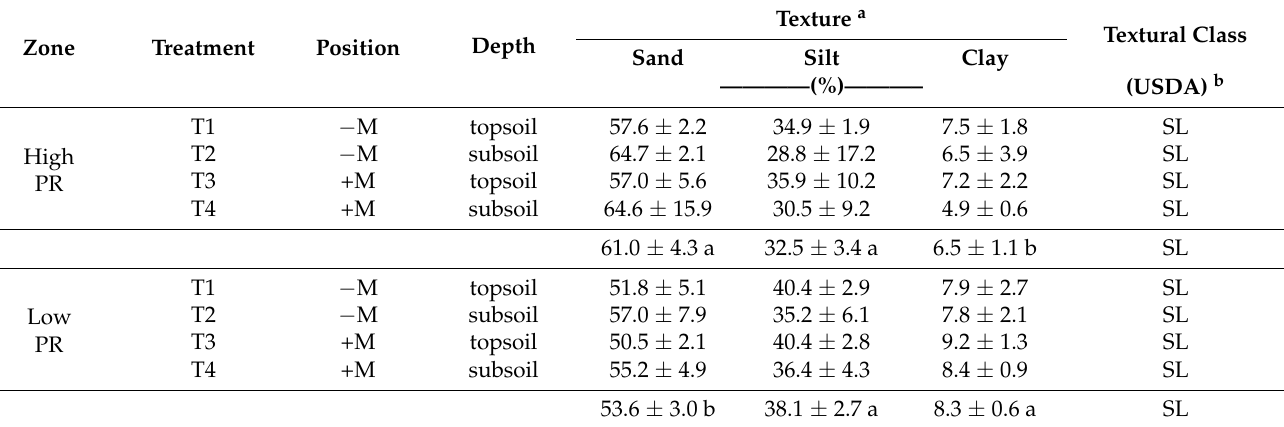
Table 1. Granulometry at the topsoil (0 – 10 cm) and subsoil (30 – 40 cm) for each area of the study site, places with frequent crossing of machinery (+M), and places without crossing ( − M). Mean ± SD.